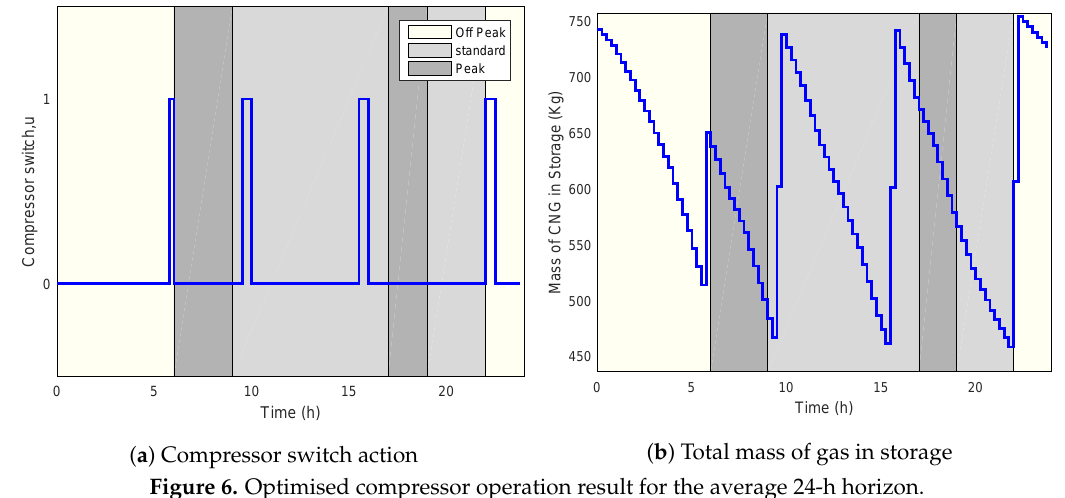
Figure 6. Optimised compressor operation result for the average 24-h